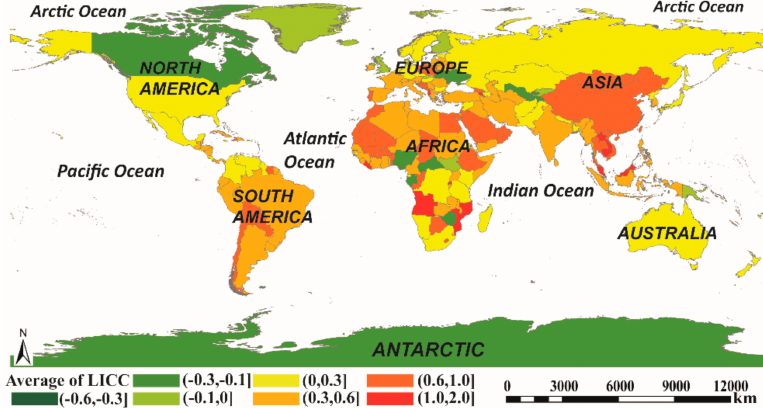
Figure 11. The avgLICC among the countries or regions.